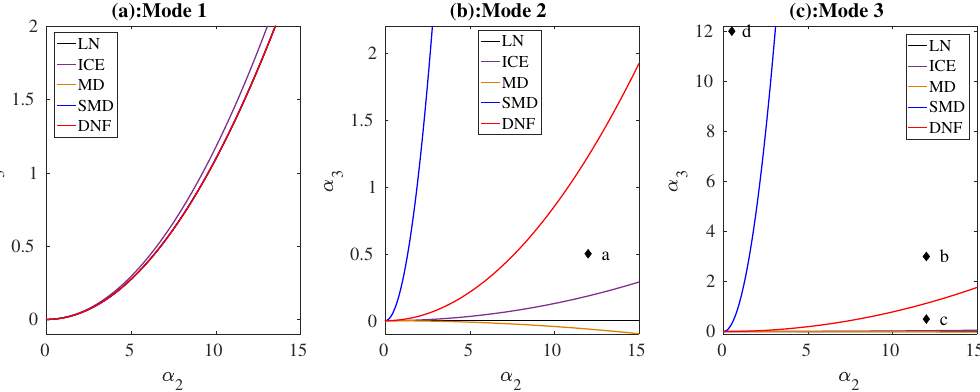
Figure 1. Hardening/softening regions in the parameter plane ( α 2 , α 3 ) for the first three modes of a simply supported beam resting on a nonlinear elastic foundation. ( a ): Mode 1, ( b ): Mode 2, ( c ): Mode 3. In the legend, LN: single linear mode; ICE: implicit condensation and expansion; MD: quadratic manifold (QM) with full modal derivatives; SMD: QM with static modal derivatives; DNF: single nonlinear normal mode built from the normal